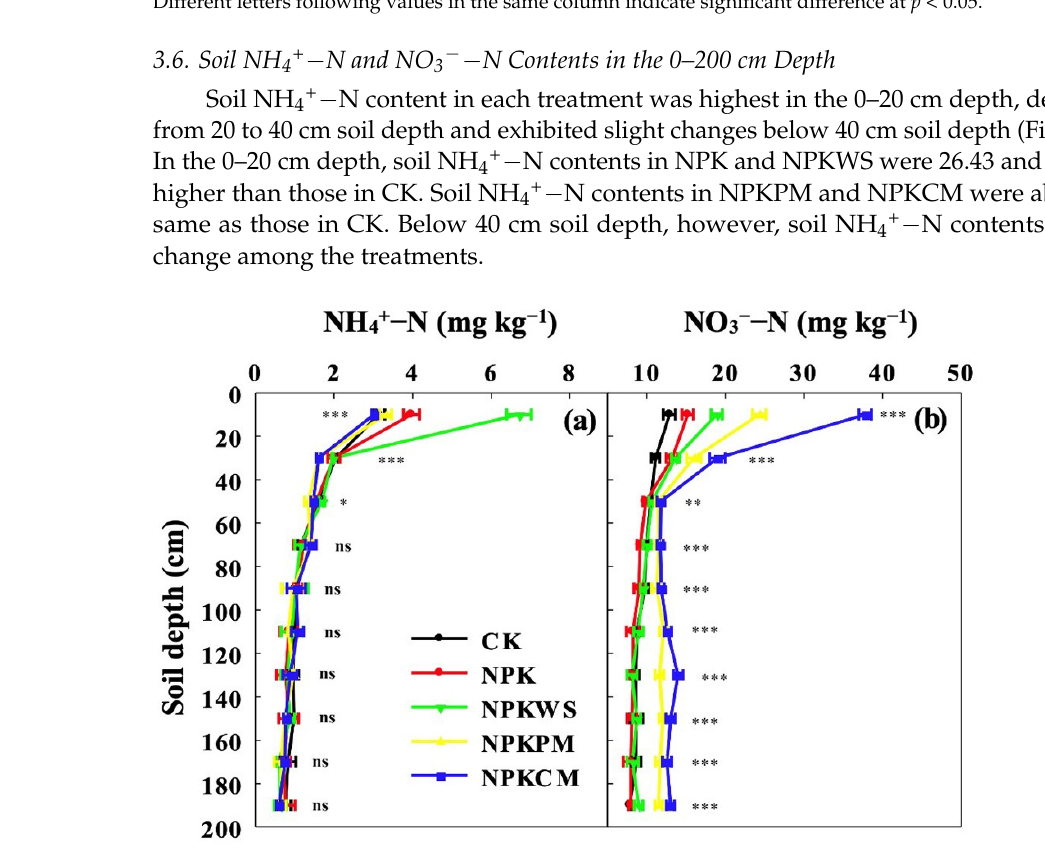
Figure 4. Soil NH 4+ − N and NO 3 − − N contents in the 0–200 cm depth after 32 years of fertilization in Vertisols. ( a ) Soil NH 4+ − N and ( b ) soil NO 3 − − N. CK: no fertilization; NPK: chemical